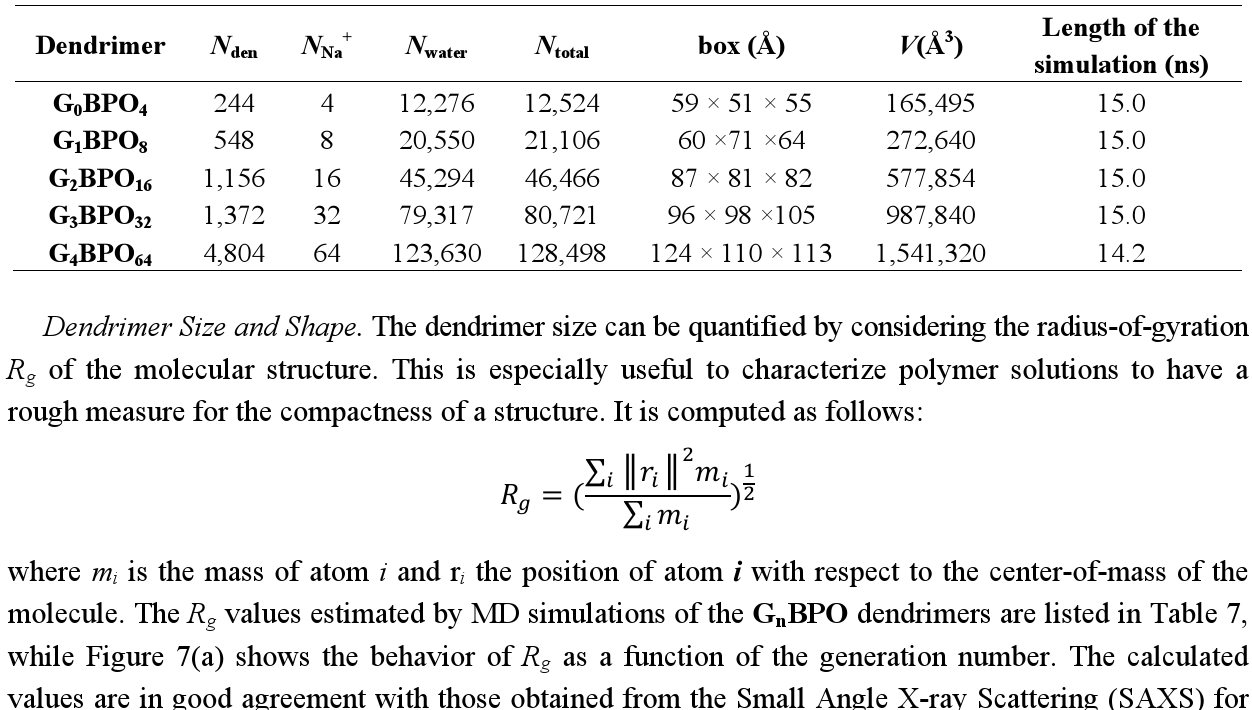
, N , N , and N are, den Na + water total Length of the simulation (ns)